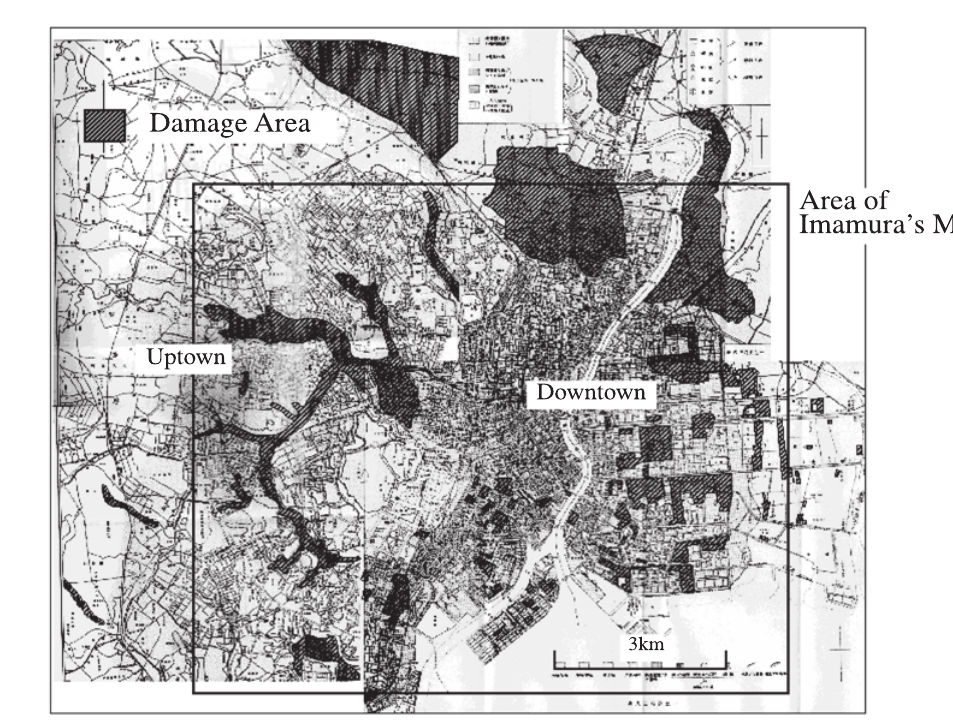
Fig. 2. Damage distribution in Tokyo during the 1923 Kanto earthquake (Geological Survey of Japan,